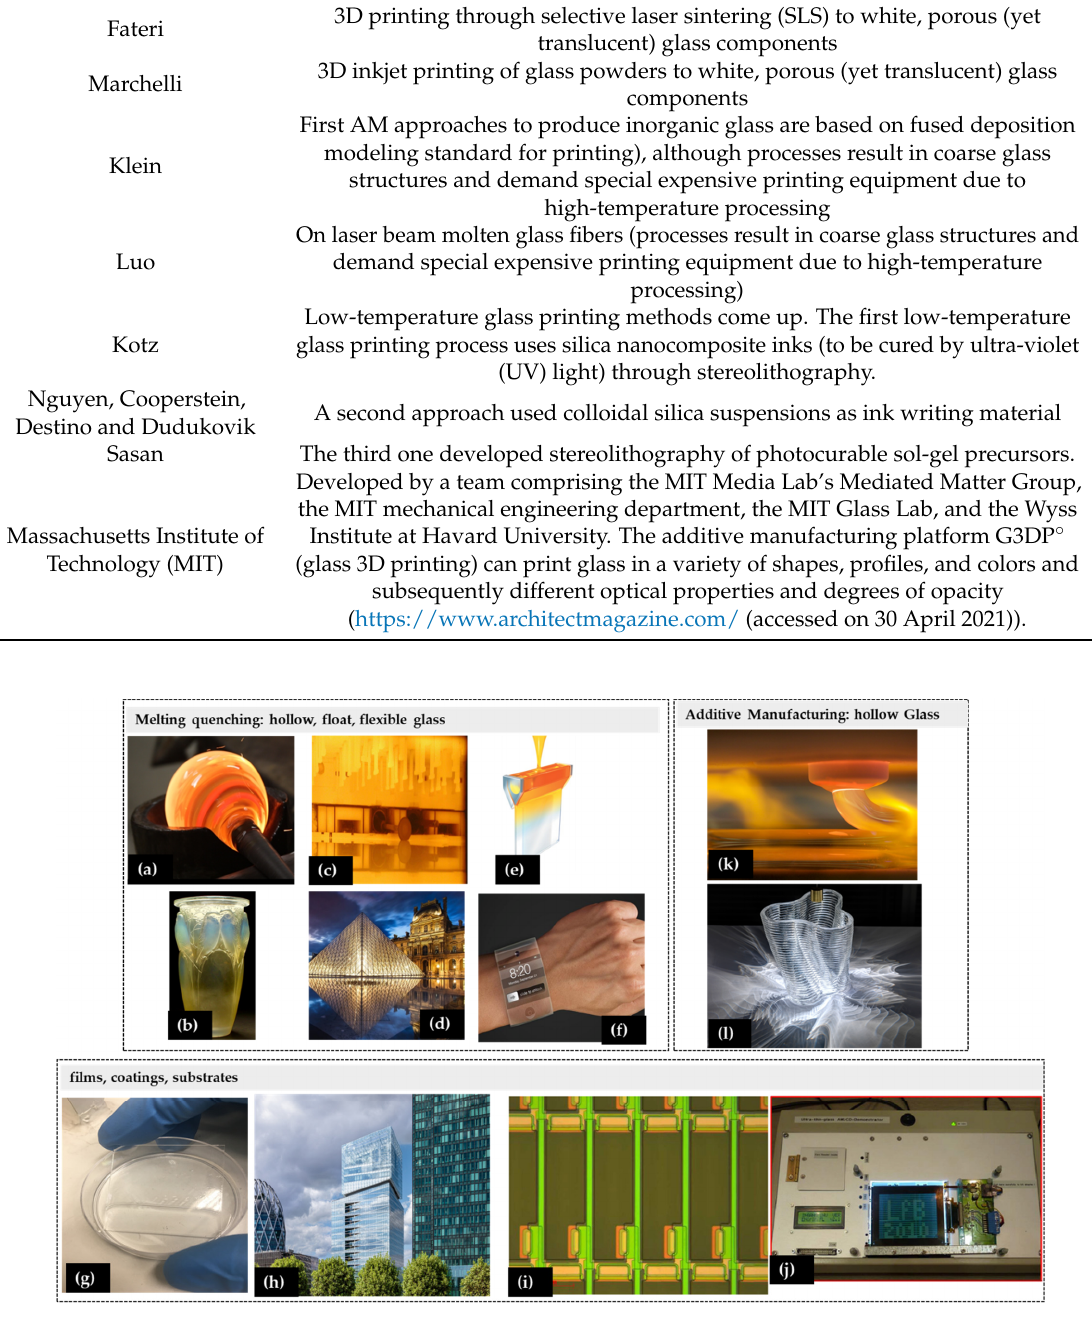
Figure 2. Examples of different glass fabrication methodologies. Melting-quenching: ( a ) glassblowing; ( b ) Lalique glass;